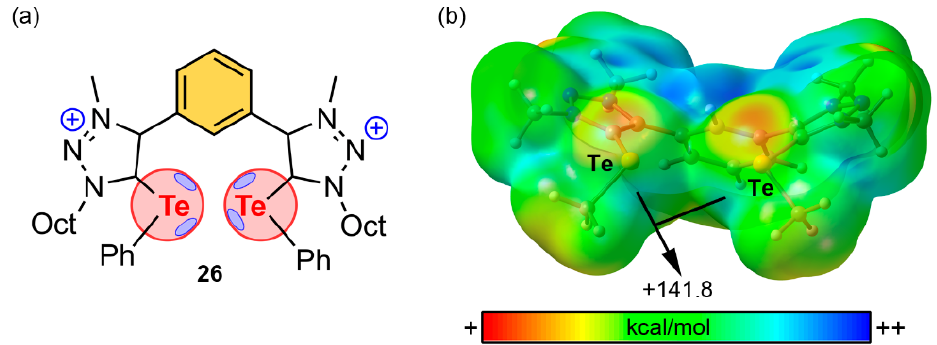
Figure 17. ( a ) Schematic view of compound 26 and ( b ) its MEP surface analysis at the B3LYP/def2- TZVP level of theory (Ph and Oct groups have been replaced by Me groups for sake of clarity). Energy value in kcal/mol (0.001 a.u.).